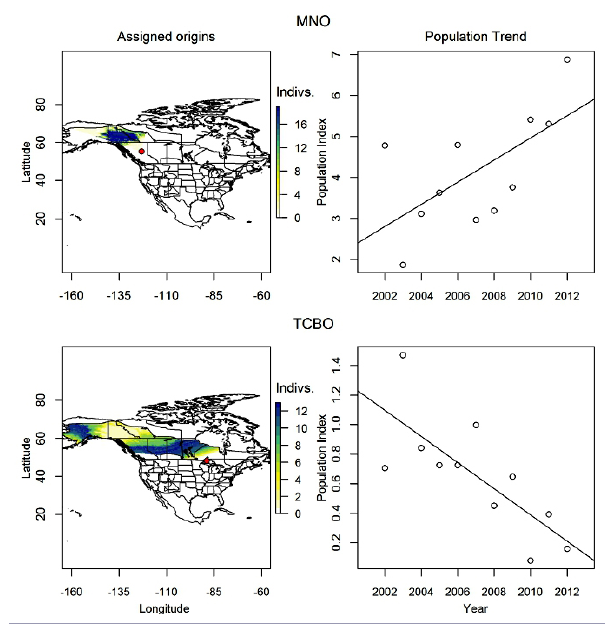
Fig. 11 . Contrasting assigned origins (left-hand panels) and population trends (right-hand panels) of Orange-crowned Warbler ( Oreothlypis celata ) from migration monitoring during the fall at Mackenzie Nature Observatory (MNO) and Thunder Cape Bird Observatory (TCBO). Red dots indicate locations of Canadian Migration Monitoring Network stations used in the analysis. Scales indicate the number of individuals that were isotopically consistent with similarly colored pixels in the map given (left-hand panels). Population indices and trends are available from http://www.bsc-eoc.org/birdmon/cmmn/